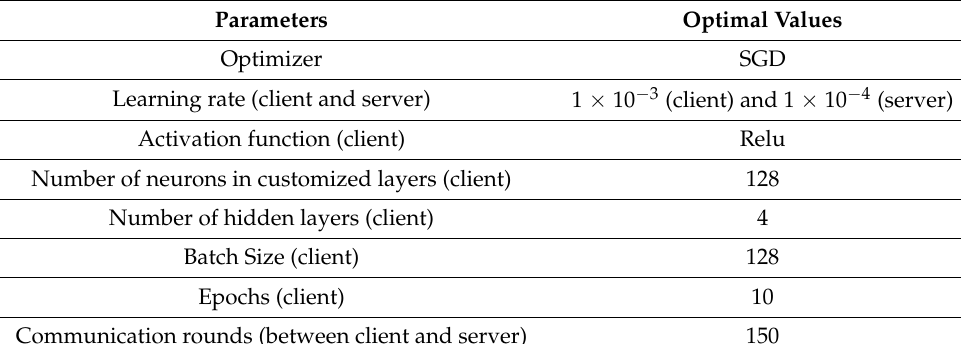
Table 4. Hyperparameters and their optimal